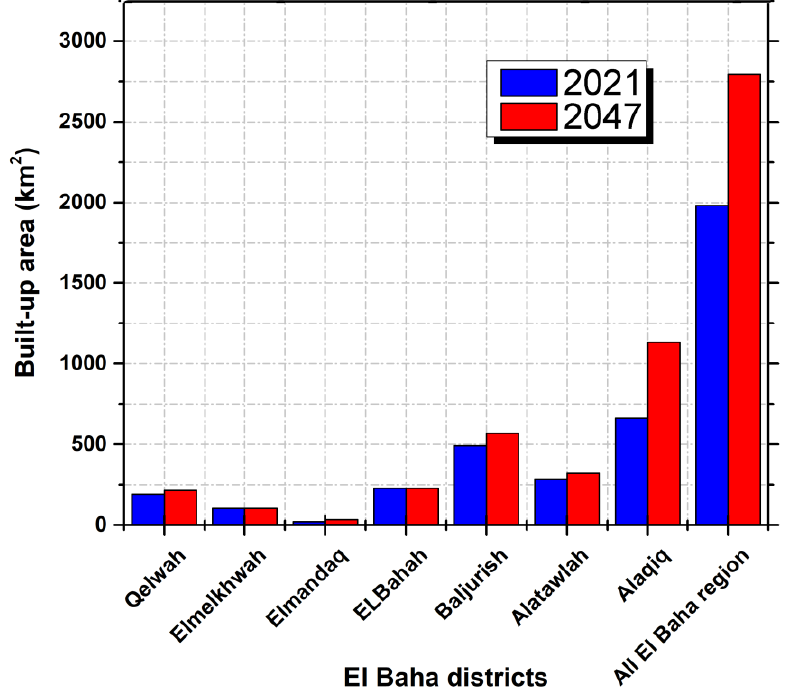
Figure 15. Area of built-up areas for all district of the El Baha region for the years 2021 and 2047.